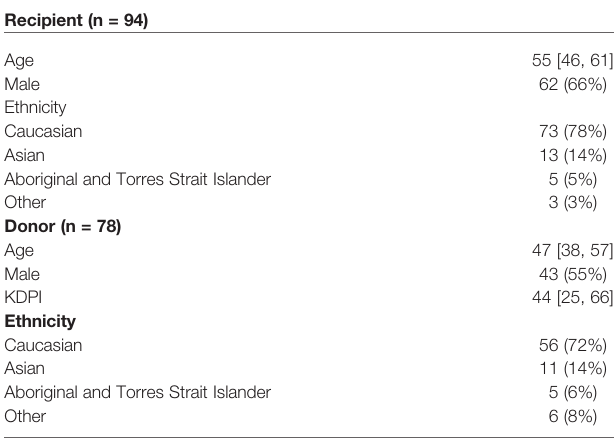
TABLE 1 | Baseline characteristics of the study cohort.